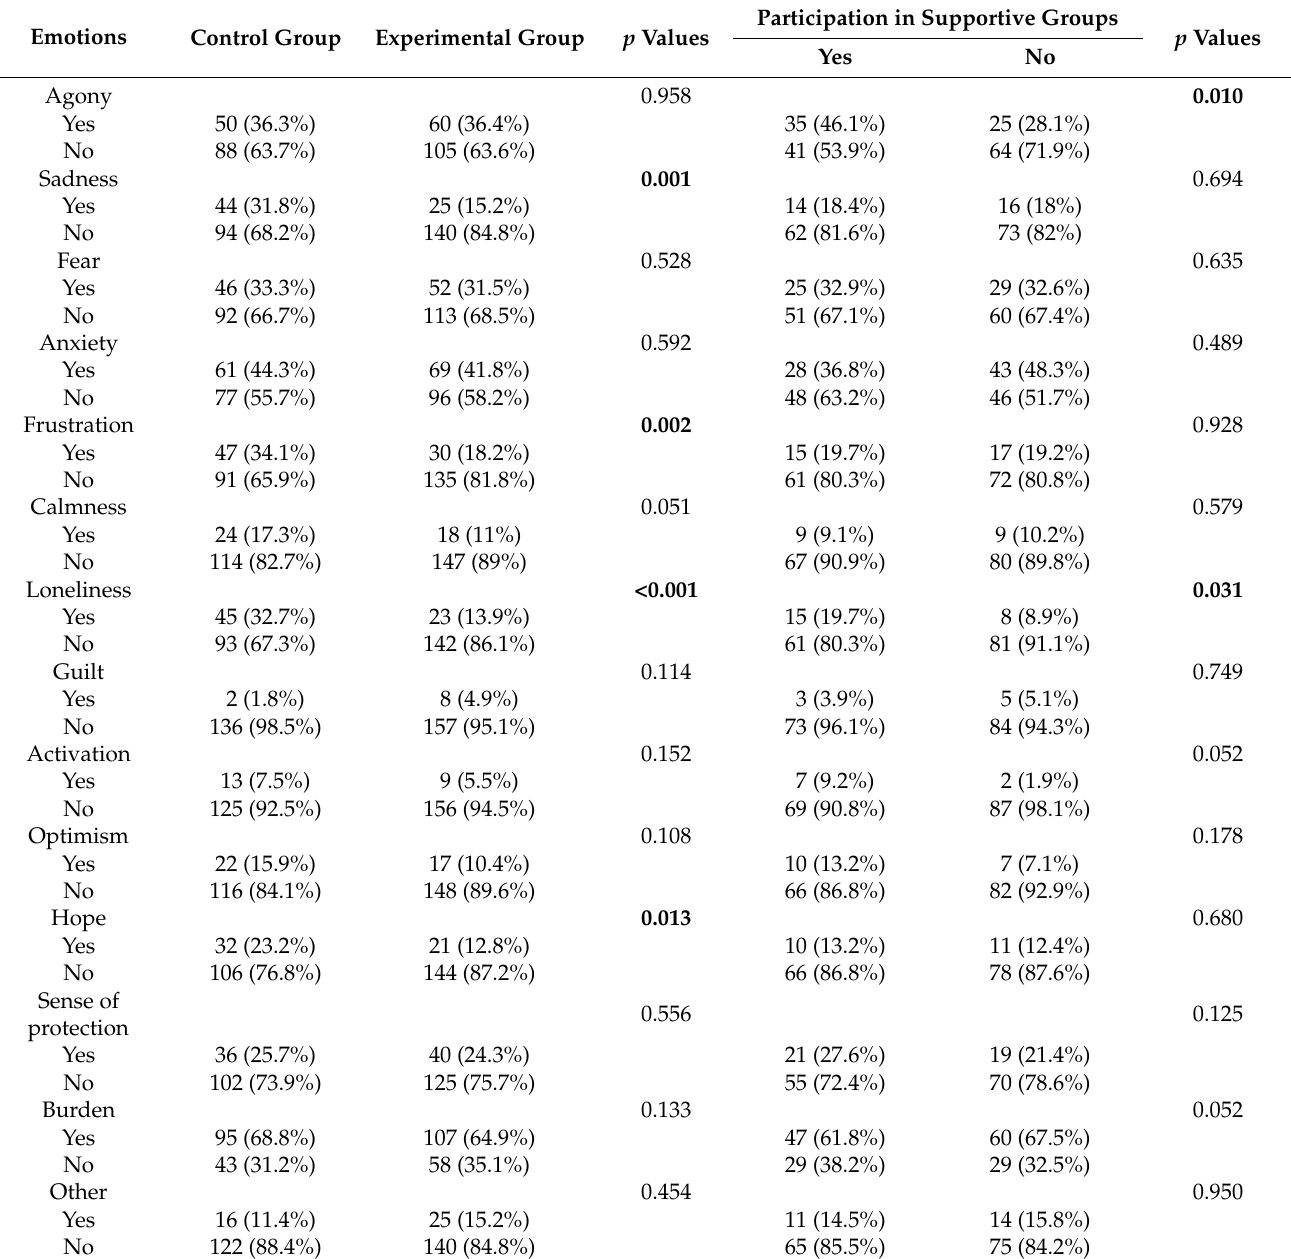
Table 5. Emotional function during the pandemic— Emotional experience